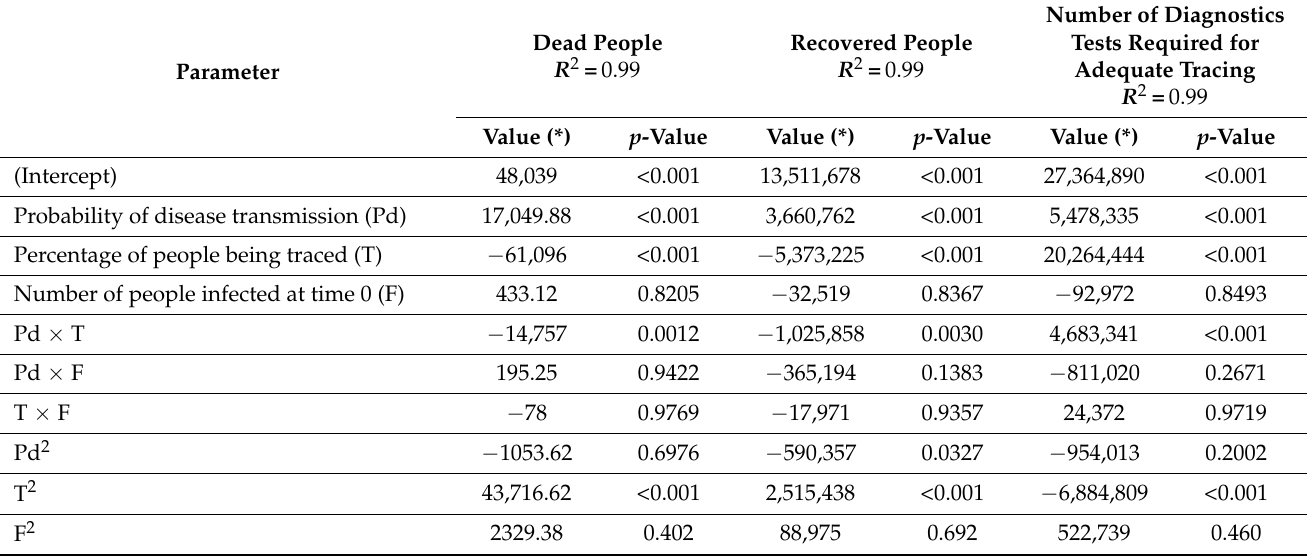
Figure 1. Graphs ( A , B ) show the progress of the death toll in Spain depending on the percentage of the population protected by vaccination (from 0% (V0) to 40% (V40)), with and without the application of social measures, respectively using a population dynamic P system (PDP) model over an 80-day period. Graphs ( C , D ) show the number of people recovering depending on the percentage of the population protected by vaccination (from 0% (V0) to 40% (V40)) with and without the application of social measures, respectively using a PDP model over an 80-day period. Table 4. Box–Behnken estimated values of the response surface parameters. Disease control measures: positives traced and social control